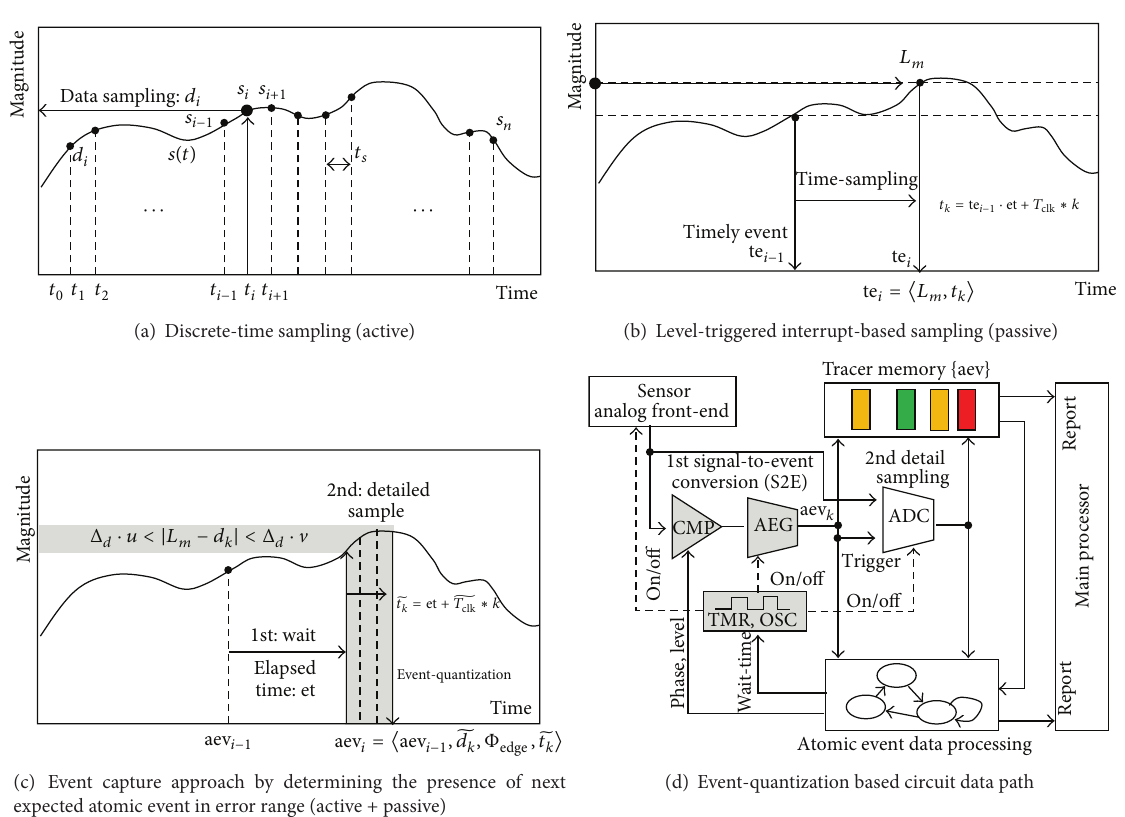
Figure 5: Event sampling illustrated and its circuit data